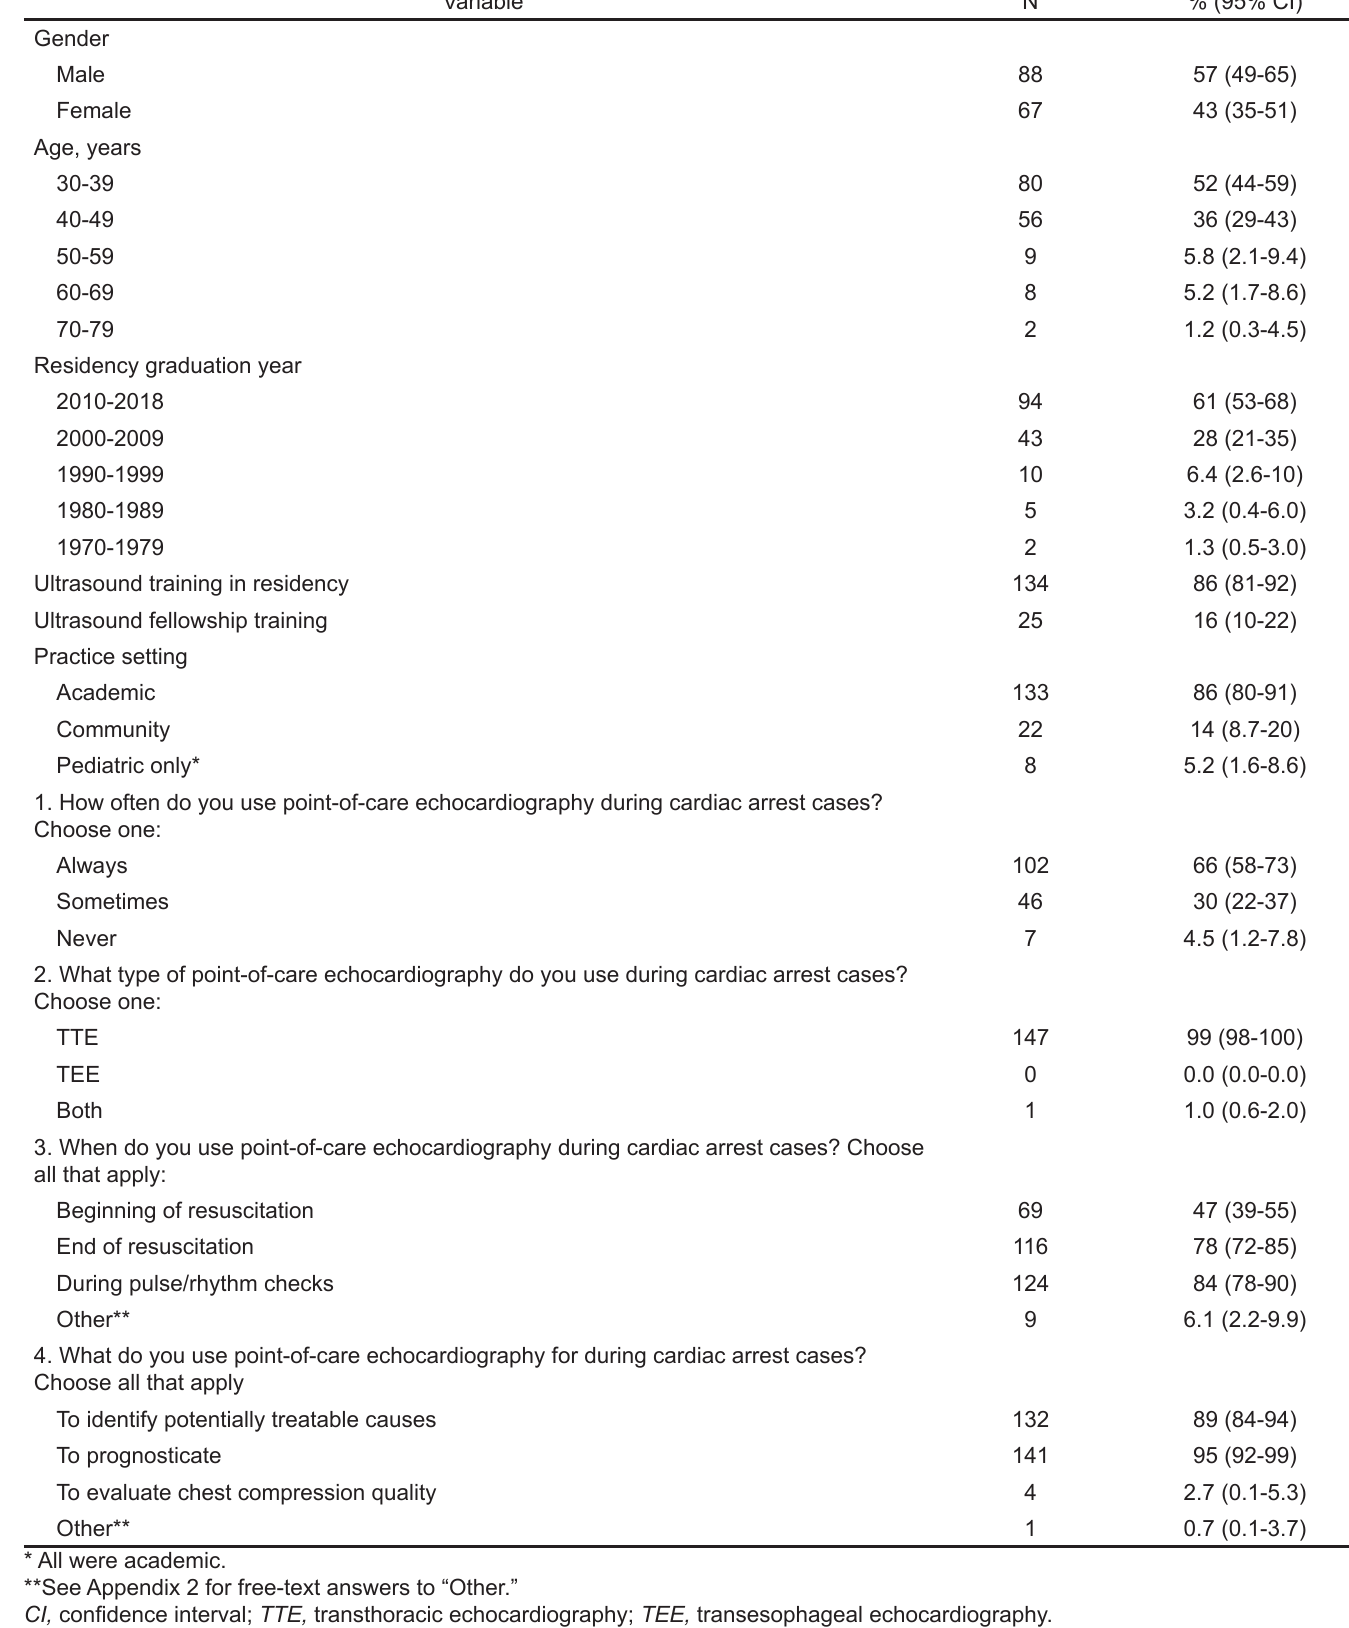
Table 1. Demographic data and answers to the echocardiography utilization